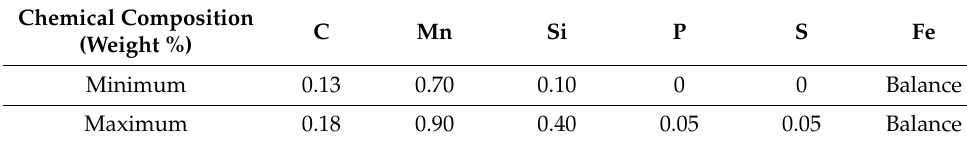
Table 1. Elemental composition of EN3B mild